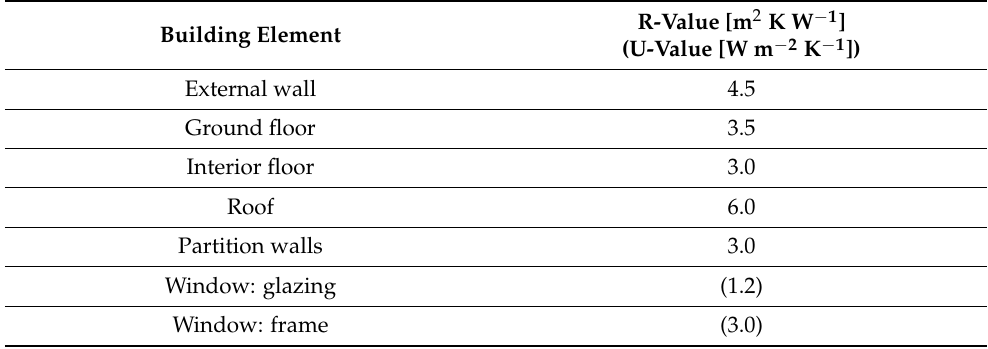
Table 4. Construction of the building